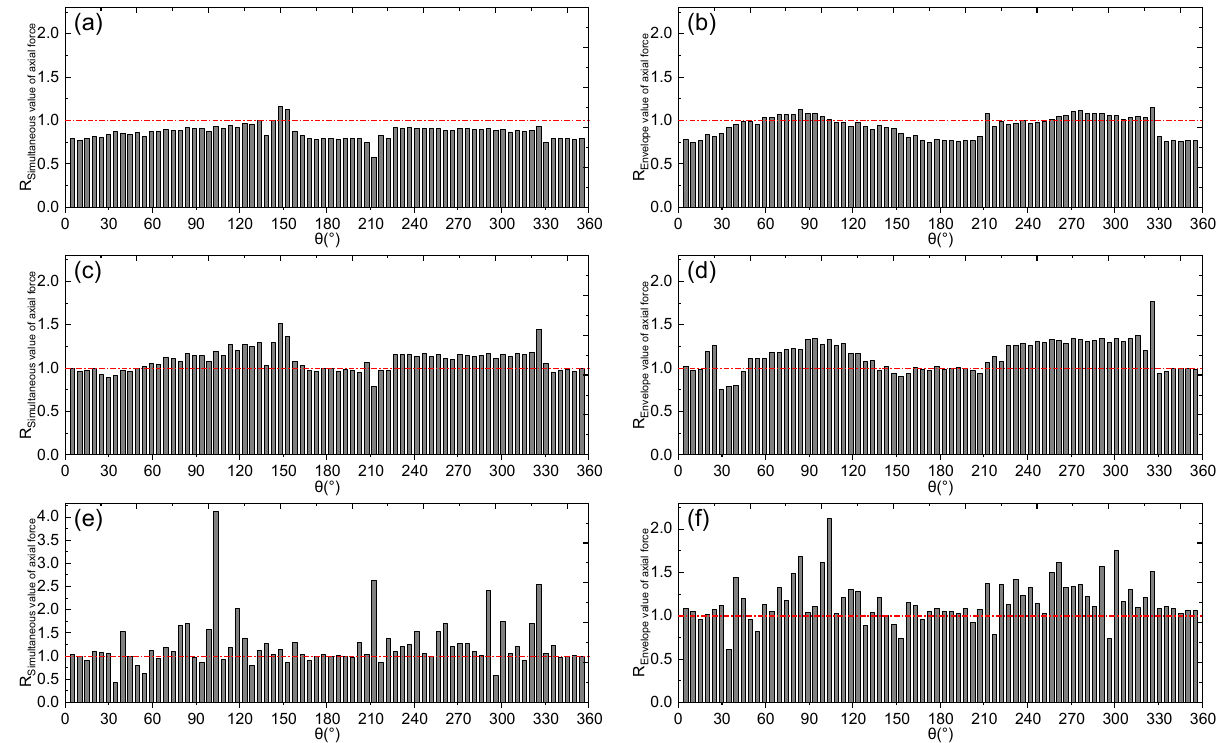
Figure 22. Dynamic response ratio of the axial force. First row ( a , b ): elastic analysis result. Second row ( c , d ): elasto-plastic analysis result. Third row ( e , f ): damage plastic analysis result.